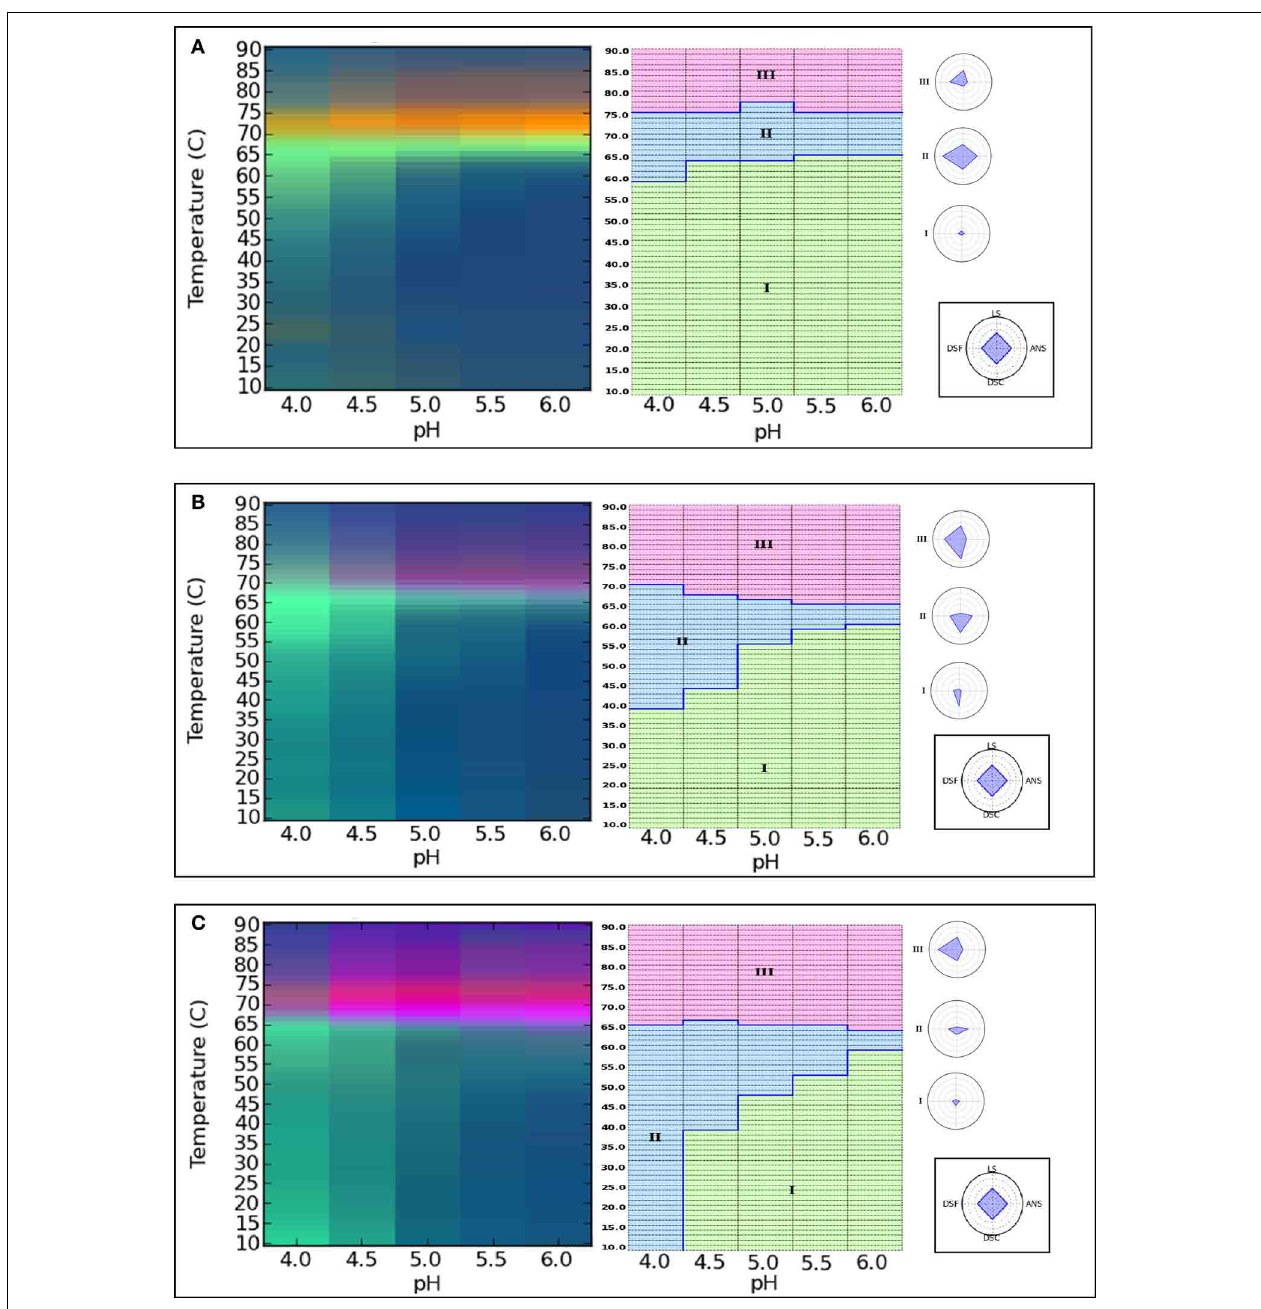
FIGURE 4 | Analysis of the conformational stability of IgG1mAb glycoforms using Empirical phase diagrams (left panel) and Radar charts (right panel). The diagrams show conformation stability of fully glycosylated (control) (A) , partially deglycosylated (B) and fully deglycosylated (C) IgG1mAb. Stability data as function of pH and